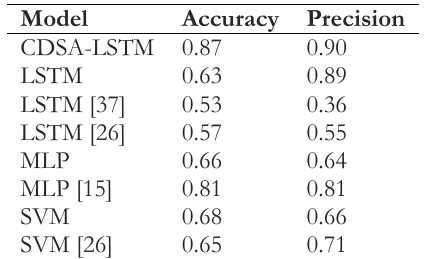
Table 4. Performance comparison against literature studies.